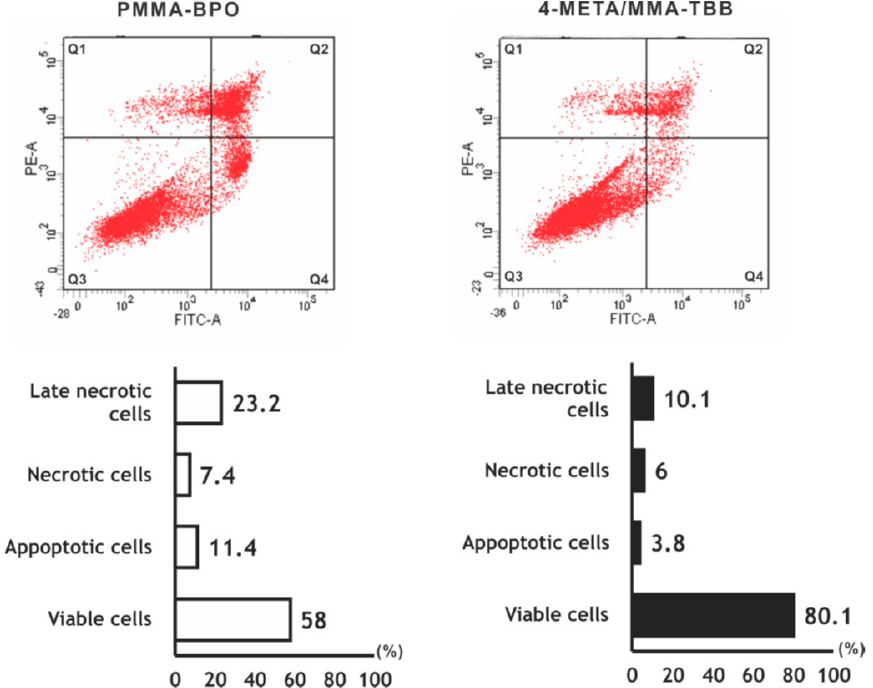
Figure 3. Flow cytometry-based viability/death analysis of osteoblasts seeded on two different materials. Cells 24 h after seeding were analyzed. Flow cytometric images (top) and percentages of viable cells (Q3 in top images), apoptotic cells (Q4), necrotic cells (Q1), and late necrotic cells (Q2). Int. J. Mol. Sci. 2019 , 20 , x FOR PEER REVIEW